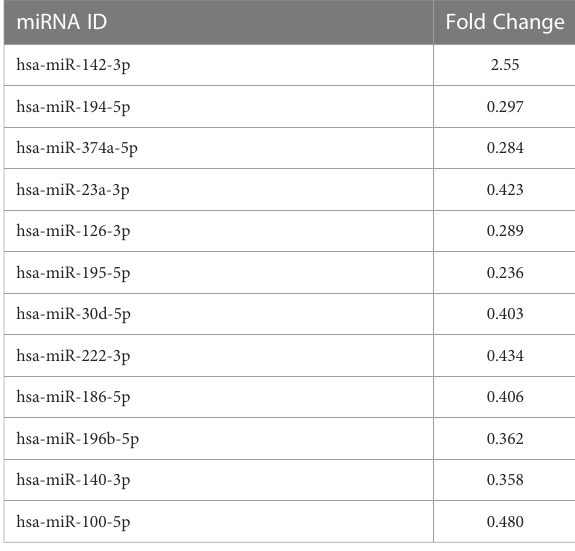
TABLE 3 Results of dysregulatedmiRNA inM0 THP-1 treatedwith sEV PBDE+LPS